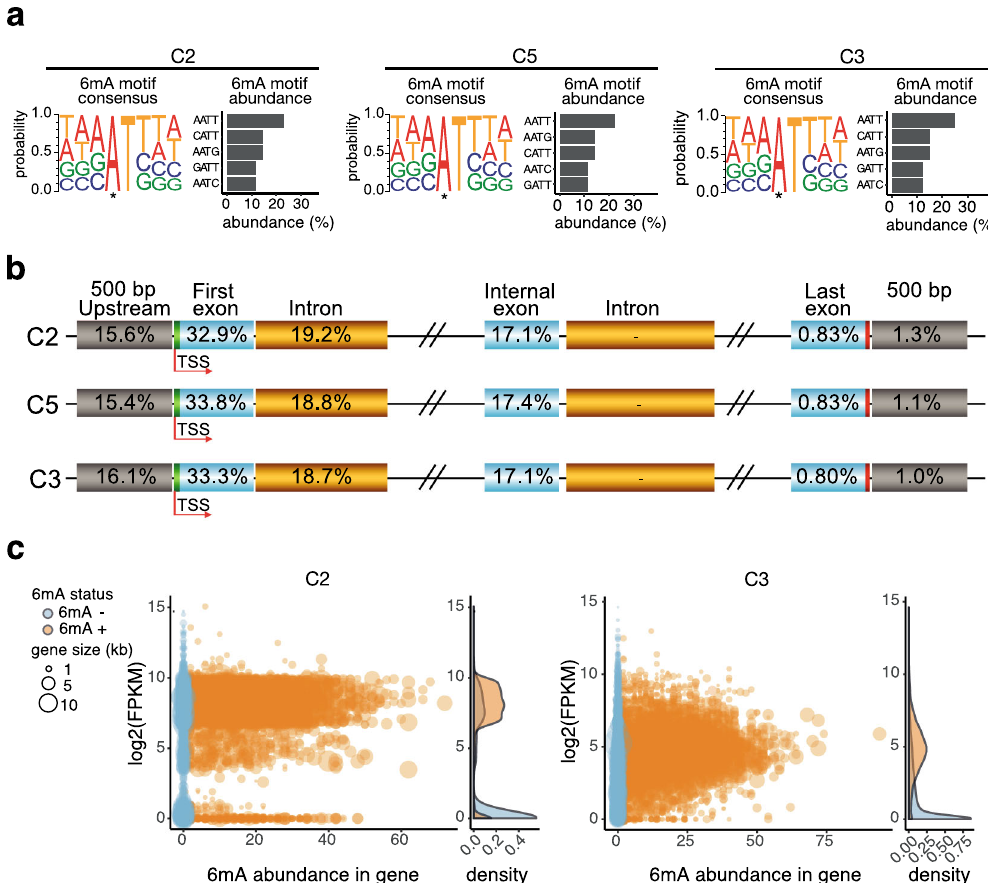
Fig. 3 Characterization of 6mA in R. irregularis isolates. a 6mA consensus sequence motifs with the probability of occurrence of each motif and the most abundant motifs in isolates C2, C5, and C3 arranged in decreasing abundance. Several ApT motifs other than AATT, CATT, AATG, GATT, and AATC were also present in each of the three isolates and in similar proportions among the three isolates. * Represents the methylated base. Data available in Supplementary Data 2. b Topological distribution of 6mA ApT dinucleotides in the gene structure in C2, C5, and C3. c Gene expression (log 2 (FPKM)) in isolates C2 and C3 of genes based on 6mA ApT abundance within gene bodies (6mA + : orange; 6mA-: blue). Gene size is represented by circle size and density curves representing the occurrence of genes with 6mA abundance (6mA + : orange; 6mA − : blue) with respect to gene expression log 2 (FPKM) values. The data are available in Supplementary Data